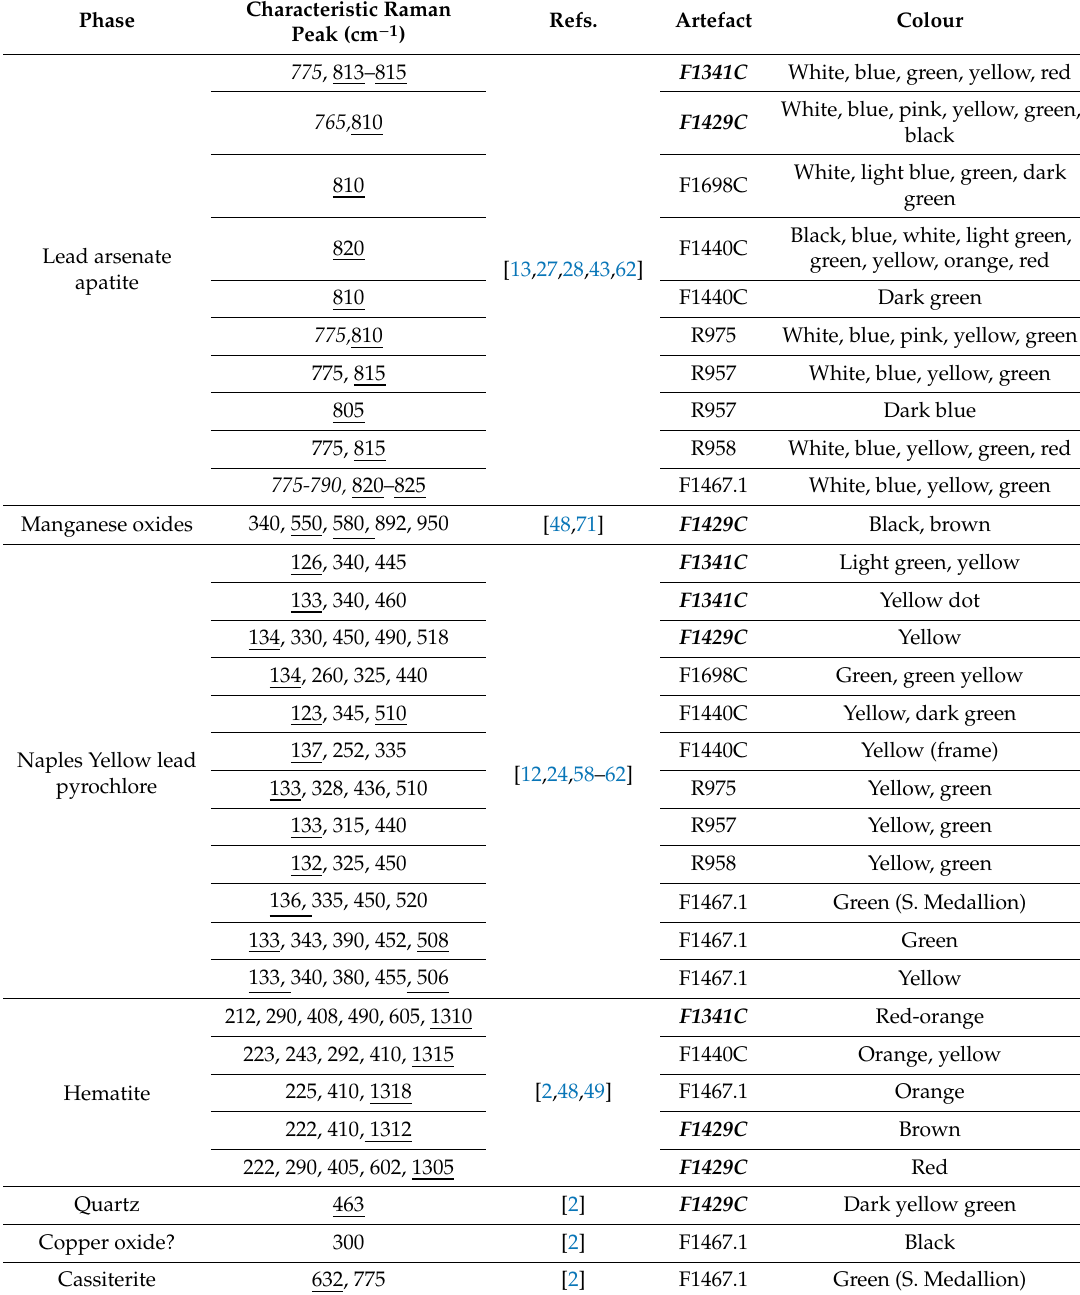
Table 4. Crystalline phases identified in the painted enamels (strongest; shoulder; porcelain: in bold italics